Question: Give a one-sentence summary of this figure.
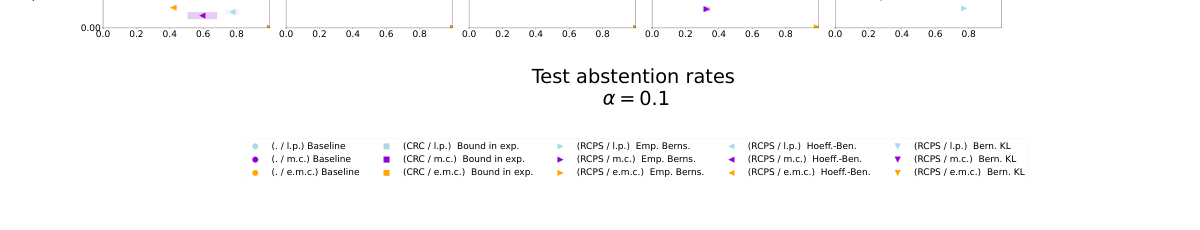
Answer: Abstention rates vs. average test losses on the Temporal Sequences dataset with α = 0.05 (top) and α = 0.05 (bottom) for score functions match count (m.c.), expected match count (e.m.c), and the log-probability (l.p.), and for various calibration methods (. denotes the baseline with no calibration). Box widths and heights represent 90% confidence intervals with Gaussian approximation over abstention rates and average test errors, respectively. The dashed horizontal line represents the target risk bound α.